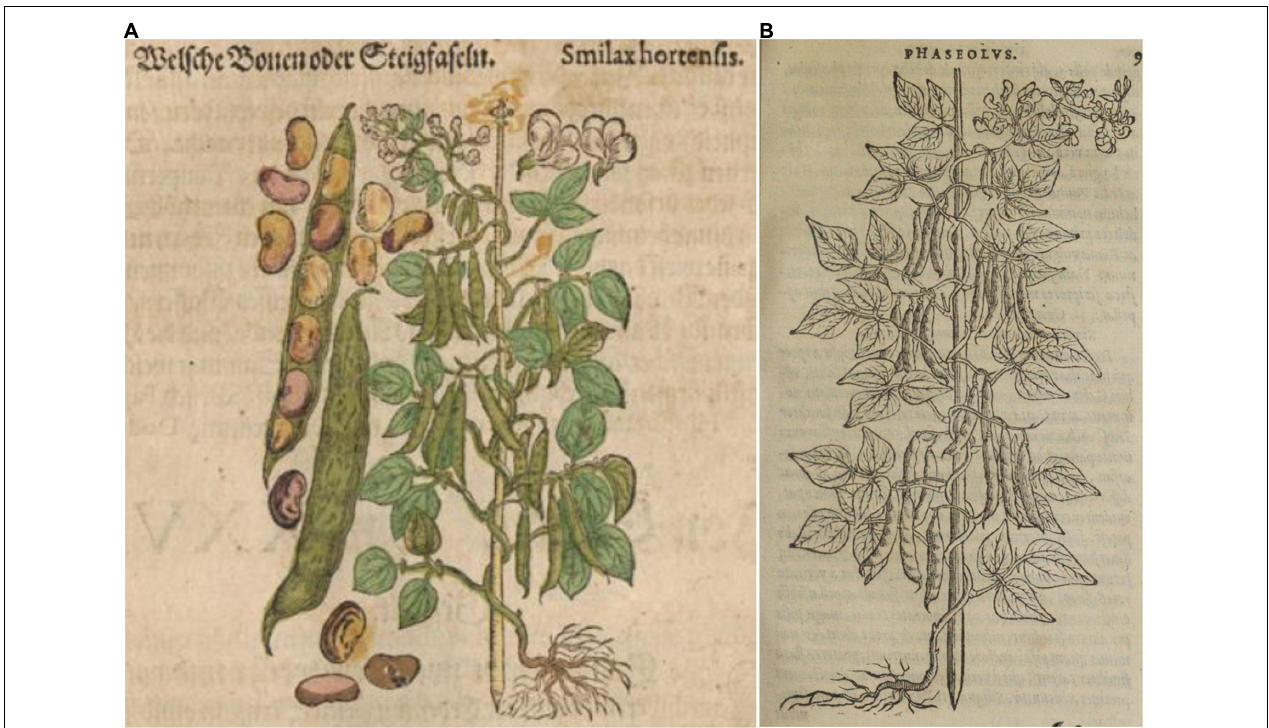
FIGURE 6 | Woodcuts of common beans from 16th century herbals. (A) Mattioli (1590) Kreutterbuch de β hochgelehrten unnd weitberühmten ... This illustration is a reverse image of panel (B) , with the addition of pods, seeds, and flowers. Source: Public domain; Universitats- und Landesbibliothek Dusseldor DE. (B) Dodoens (1566), Frumentorum, leguminum, palustrium et aquatilium herbarum ... Source: Public domain; Wellcome Library, London, United Kingdom (Proquest).